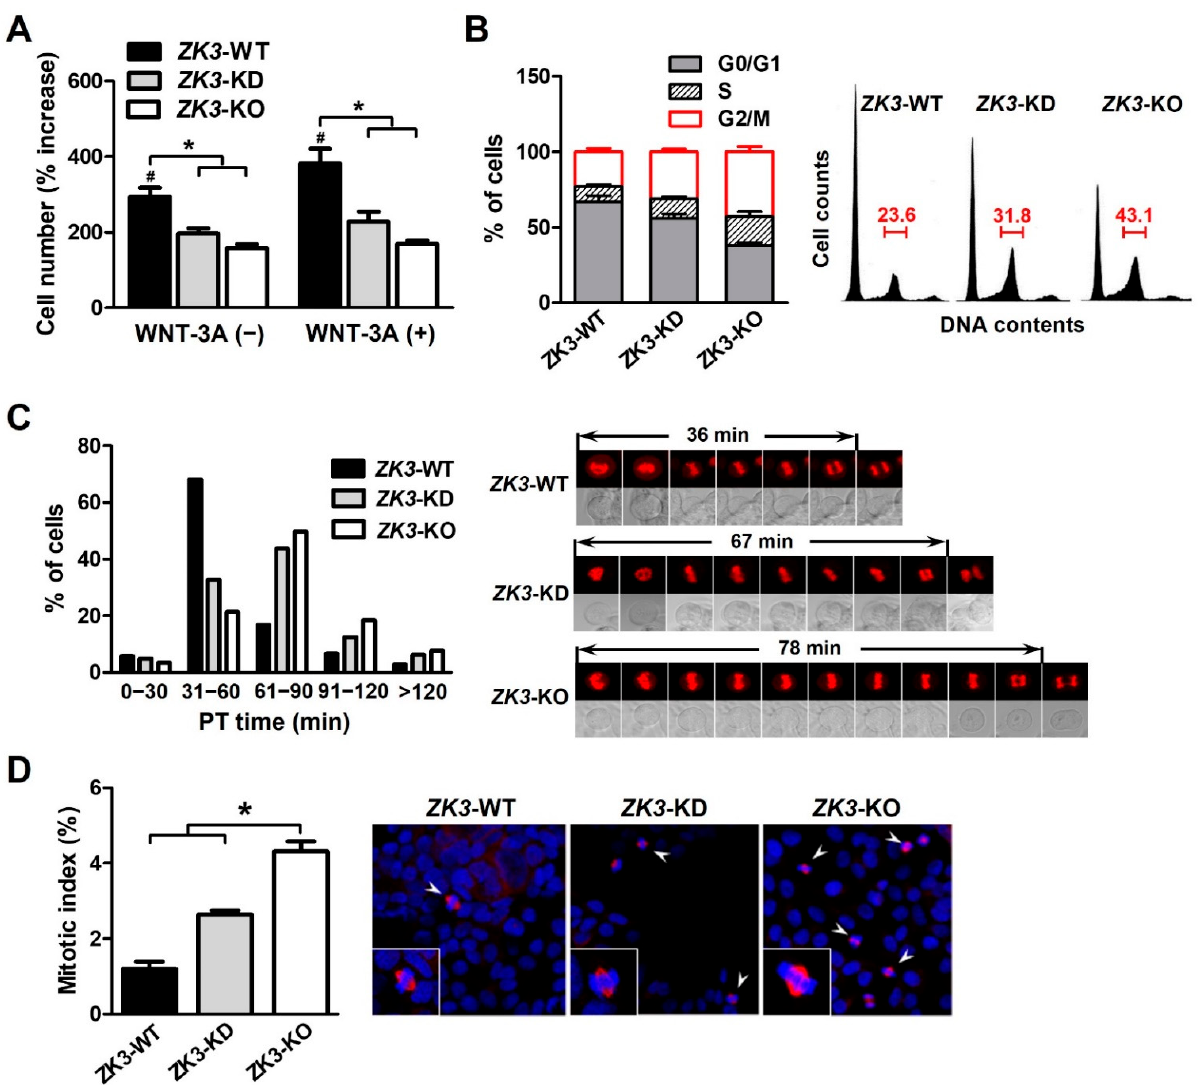
Figure 4. ZKSCAN3 deficiency delays the progression of mitosis. ( A ) Cell proliferation rate was determined in the presence or absence of WNT-3A through sequential monitoring with Incucyte. The cell count data were acquired 6 days after initial seeding. Data are expressed as mean ± SDs (*, # p < 0.05). ( B ) Cell cycle profiles were determined using flow cytometry after staining with propidium iodide. Histogram data were obtained from three independent experiments and are expressed as mean ± SDs. Representative flow cytometric results are shown in the right panel. ( C ) Time-lapse analysis of ZK3-WT, ZK3-KD, and ZK3-KO cells. Cells stably expressing histone 2B-RFP were cultured on a live cell chamber instrument and continuous fluorescent images were taken. The graph presents the percentage of cells at different time points in the time taken from prometaphase to telophase (PT time). A minimum of 50 cells per sample was observed. Representative images with mean PT times are shown in the right panel. ( D ) Mitotic indices were determined by counting cells, which had pairs of duplicated chromatids aligned to the center of the dividing cell (arrowhead). Unsynchronized ZK3-WT, ZK3-KD, and ZK3-KO cells were immunostained with anti- α -tubulin antibody, and nuclei were stained with DAPI. Individual cells are magnified in the box. A minimum of 200 cells were counted on three slides. The histogram displays the mean ± SD of triplicate measurements (left panel). Representative images are shown in the right panel. Statistical significance was determined using the Kruskal–Wallis test (* p < 0.01).